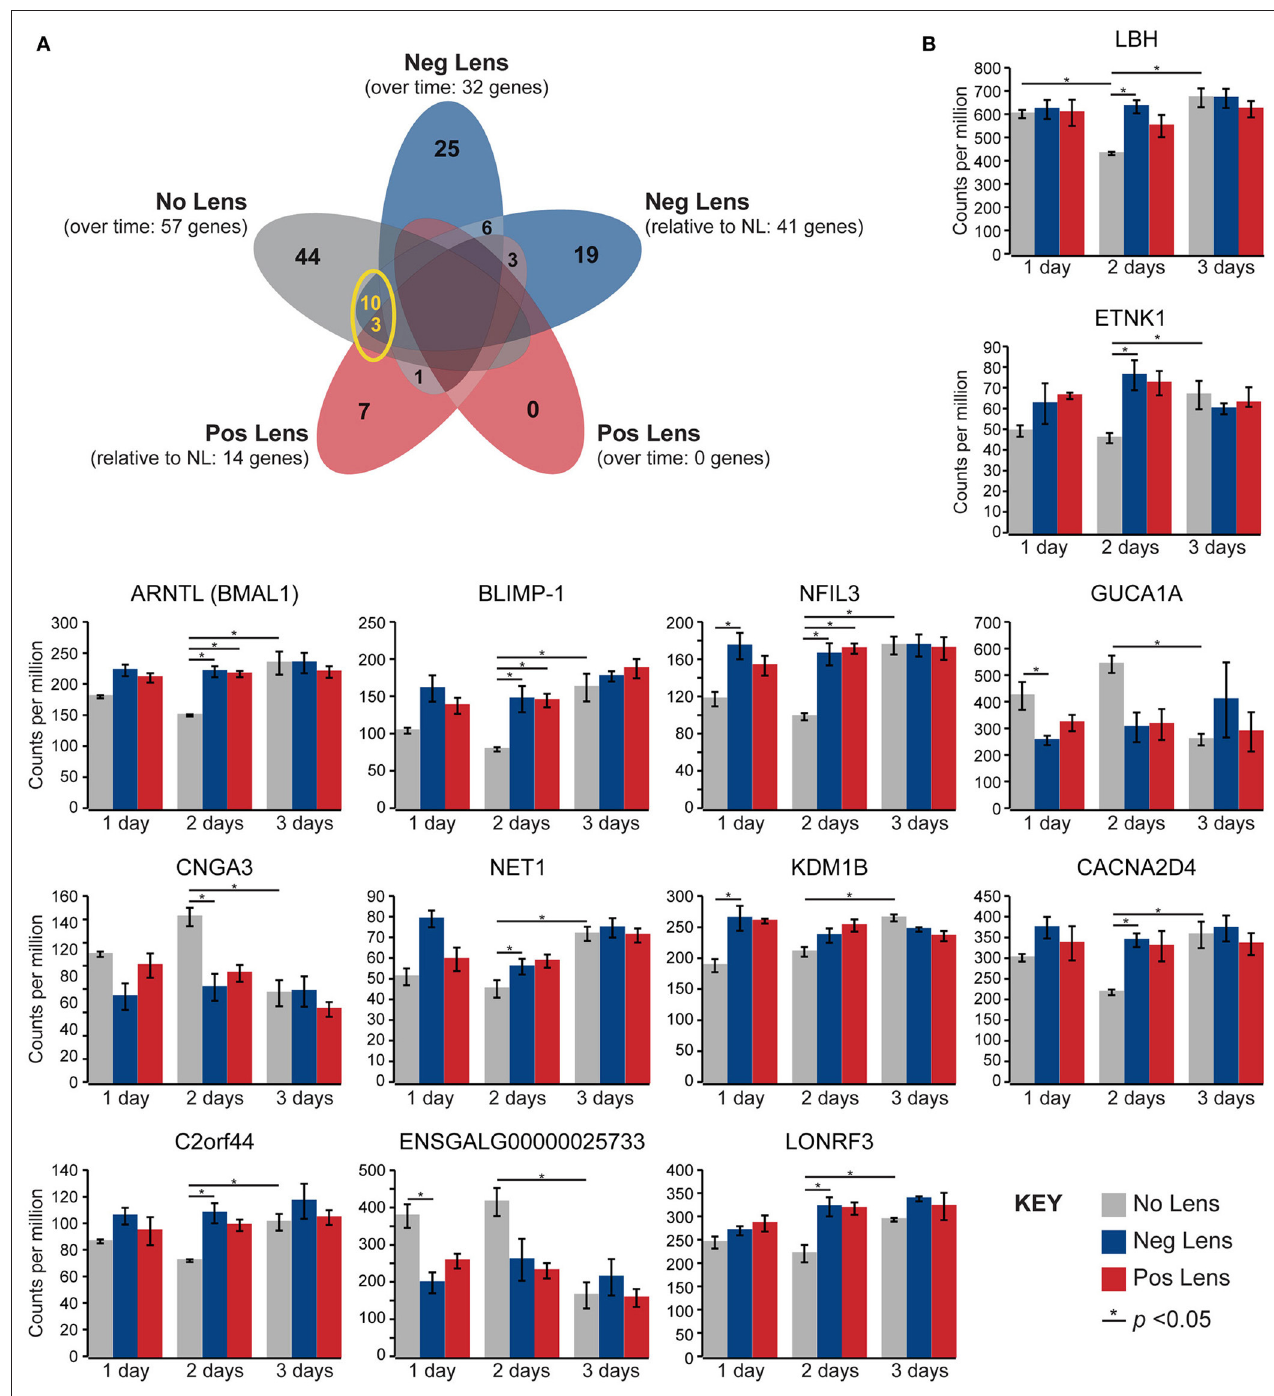
FIGURE 4 | Lens wear accelerates the time-course of developmental shifts in circadian and phototransduction gene expression. (A) Venn diagram highlighting the number of genes that were differentially expressed across multiple conditions (i.e. overlap in gene findings between the within and across-group conditions shown in Figures 2A,B , 3A,B ). The yellow circle highlights overlap in the genes differentially expressed over time in the no lens group, and the genes differentially expressed in lens vs. No Lens comparisons at 1, 2, or 3 days. This overlap suggests that perturbation of developmental expression changes could drive some of the differences seen when comparing normal development with refractive error phenotypes. (B) Column charts showing expression (counts per million, ± SE) of each gene highlighted in (A) . Note that, for most genes, lens wear appears to accelerate the time-course of developmental expression changes.